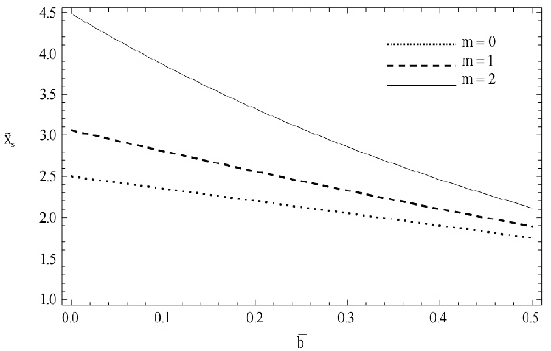
Figure 6. The growth of shock strength ( γ = 5/3.